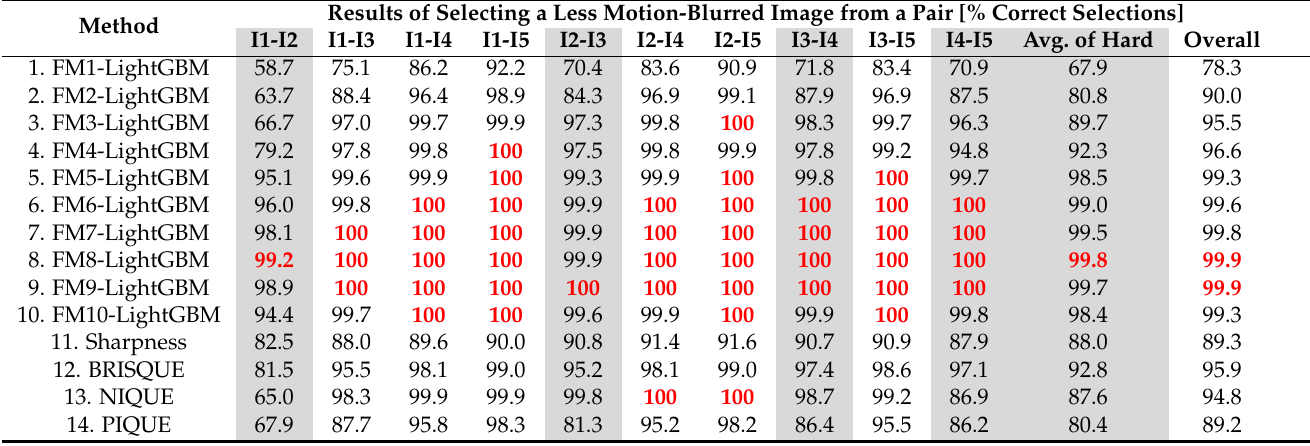
FM9 Table 4. Method comparison results of selecting a less motion-blurred image from a pair of images. Images are of real faces. Values in the table are the percentages of selections that were correct. Images in the pairs are the following: I1—original image; I2—AT+MB1 (original image altered by affine transformation + motion blur #1); I3—AT × 2+MB2 (original image altered by the previous affine each comparison group (column) is highlighted in red. The dark background of the cells highlights comparison results of harder image pairs, i.e., image pairs that are the most similar according to the motion blur